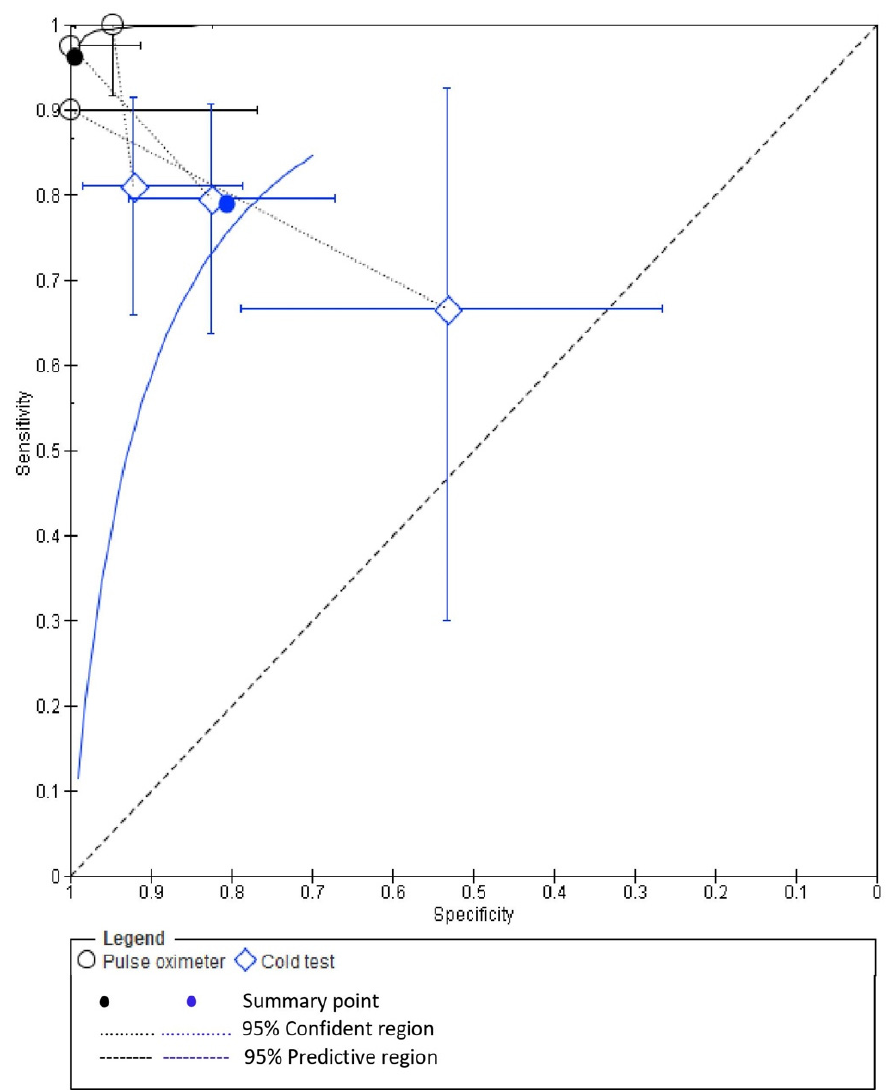
(82.0%; 95% confidence interval, 72.0% to 89.0%).